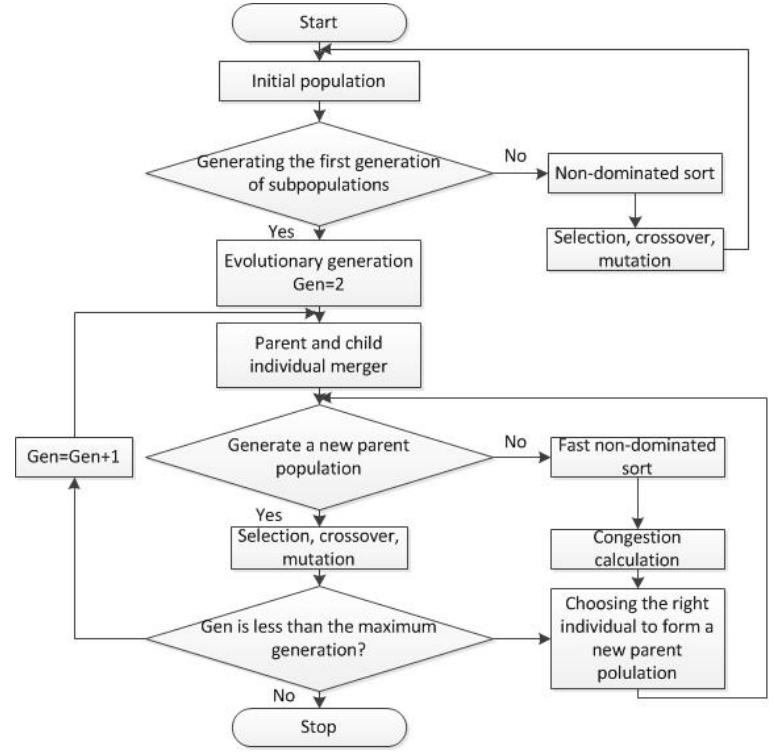
Figure 7. Non-dominated sorting genetic algorithm with elite strategy ( NSGA-II) basic process.